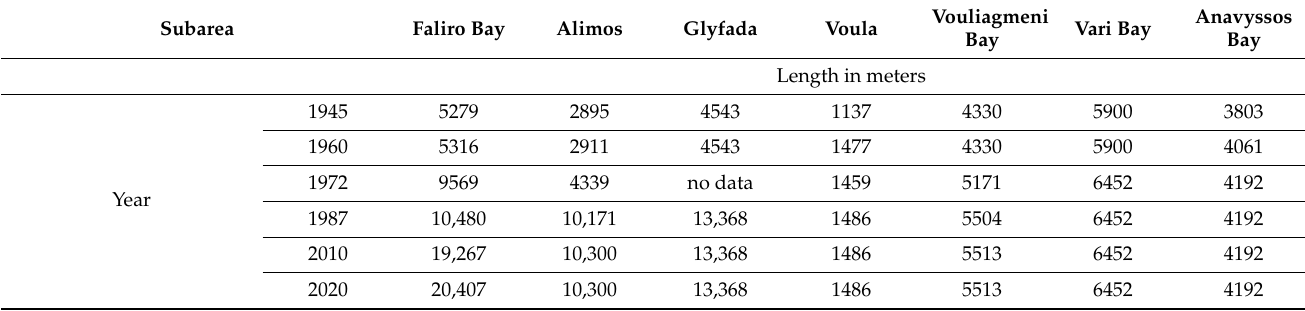
Table 2. The lengths of the coastline in each year, the changes in length (in km) and their percentage (%) between different years for each